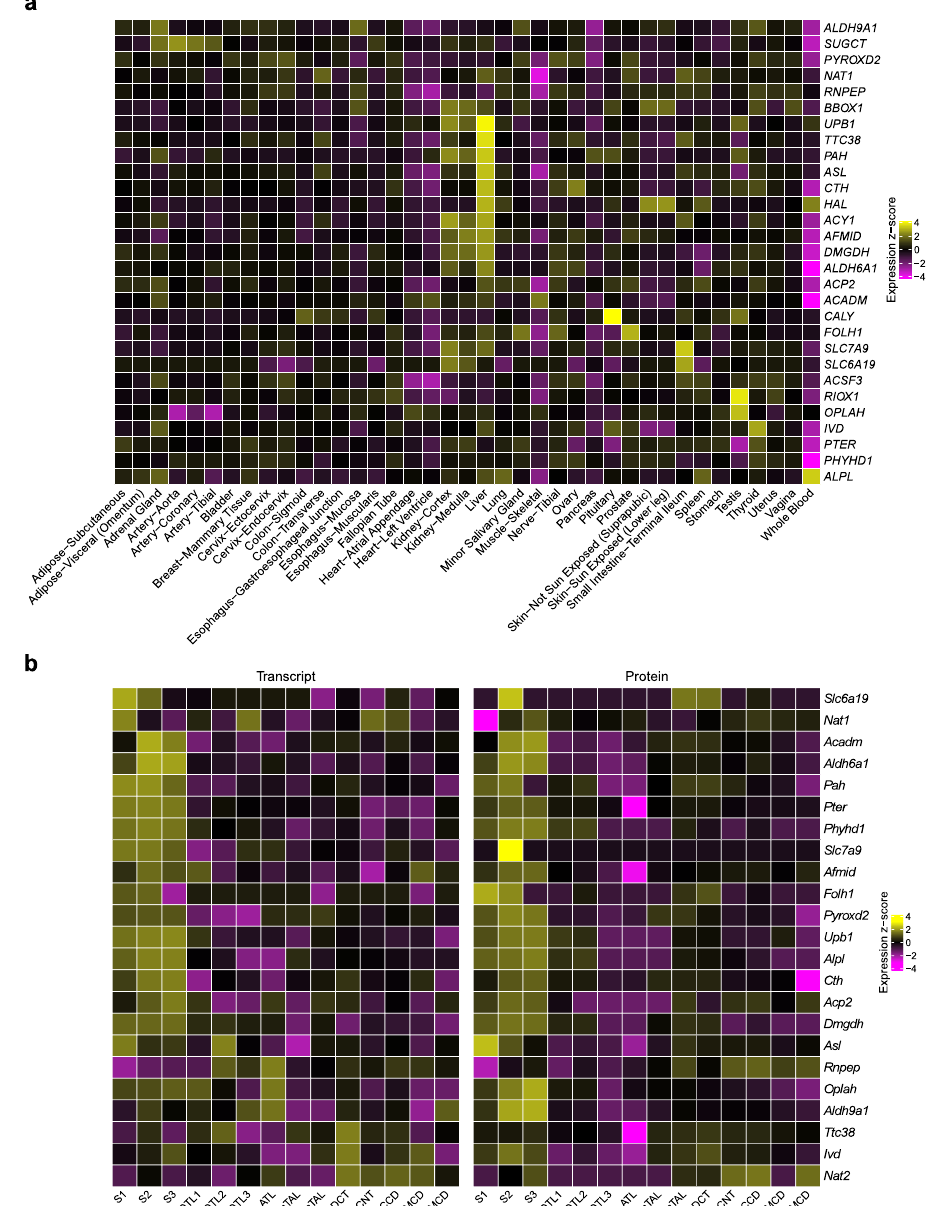
Fig. 5 Enrichment analyses highlight speci fi c tissues and cell types in which the identi fi ed genes are highly expressed. Human tissues ( a ) as well as rat micro-dissected kidney tubule cell types ( b ) were evaluated. Tissues are based on GTEx Project data V8, transcriptome data of kidney tubule cell types on the publication by Lee et al. 40 and proteome data of same cell types on the publication by Limbutara et al. 39 . a Gene expression levels are from 39 non-brain tissues from GTEx V8. Presented values are the mean of log 10 -transformed Transcript Per Million (TPM) of samples in each tissue. Only 29 genes are displayed because OR5R1 is not included in GTEx V8. b S1, fi rst segment of proximal tubule; S2, second segment of proximal tubule; S3, third segment of proximal tubule; DTL1, descending thin limb type 1 (short-looped nephron); DTL2, descending thin limb type 2 (long-looped nephron); DTL3, descending thin limb type 3 (long- looped nephron); ATL, ascending thin limb; mTAL, medullary thick ascending limb; cTAL, cortical thick ascending limb; DCT, distal convoluted tubule; CNT, connecting tubule; CCD, cortical collecting duct; OMCD, outer medullary collecting duct; IMCD, inner medullary collecting duct. Presented values are the mean of log 10 -transformed TPM of samples in each cell type. There was no rat homolog for SUGCT ; NAT1 has two homologues ( NAT1 and NAT2 ). ACSF3 , ACY1 , BBOX1 , CALY , HAL , OR5R1, and RIOX1 were not included in the transcriptome dataset. Source data are provided as a Source Data fi